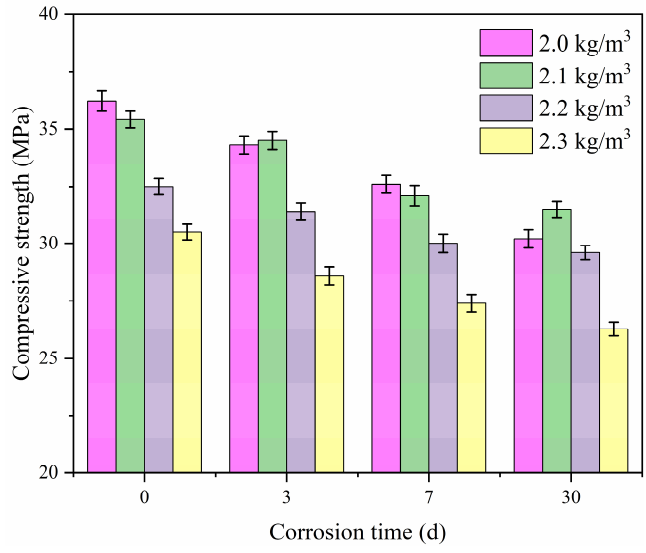
Figure 12. Compressive strength of cement samples with di ff erent corrosion times.